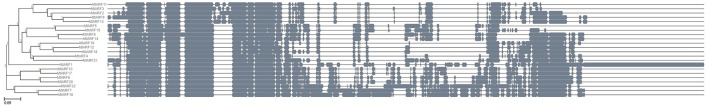
Dendrogram constructed following multiple sequence alignment for all 22 MtARFs using Clustal Omega and ETE 3 visualization framework.